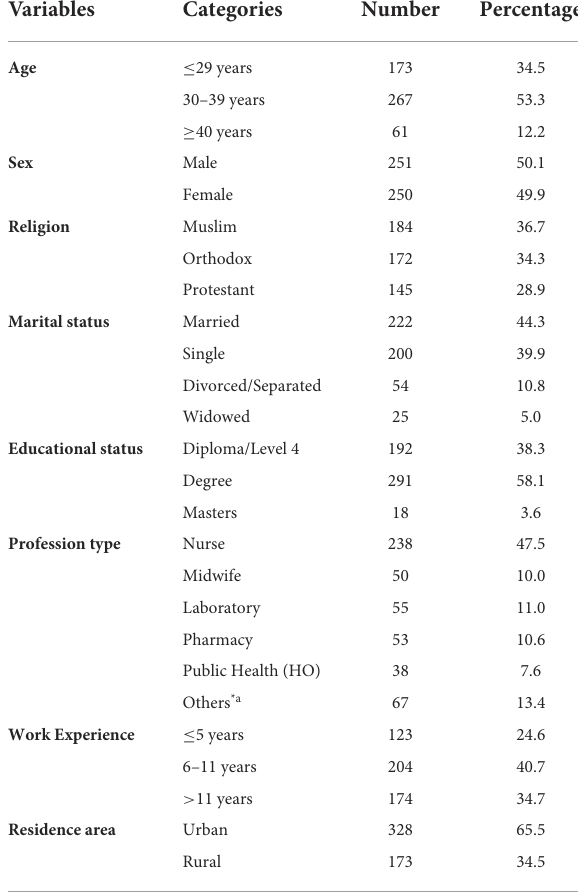
TABLE 1 The sociodemographic characteristics of healthcare professionals working at public health facilities in Dire Dawa City, Eastern Ethiopia, 2020 (n =